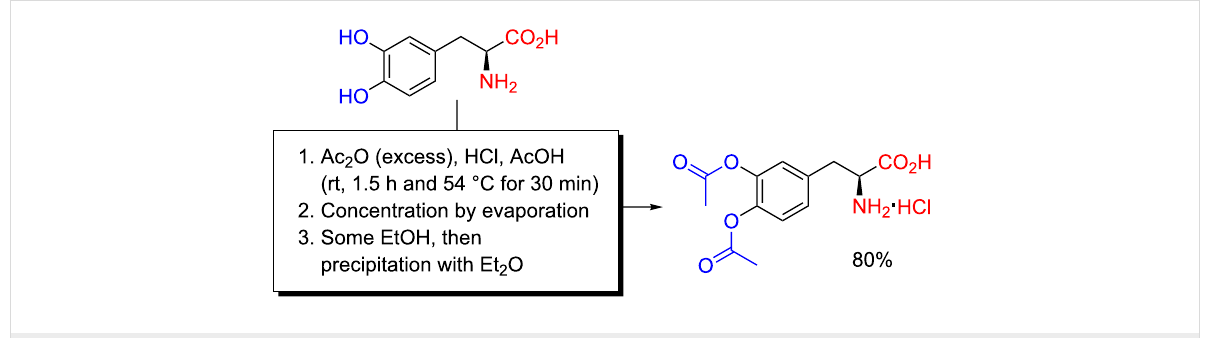
Scheme 7: Chemoselective O -acetylation of L-DOPA as reported by Fuller, Verlander and Goodman in 1978